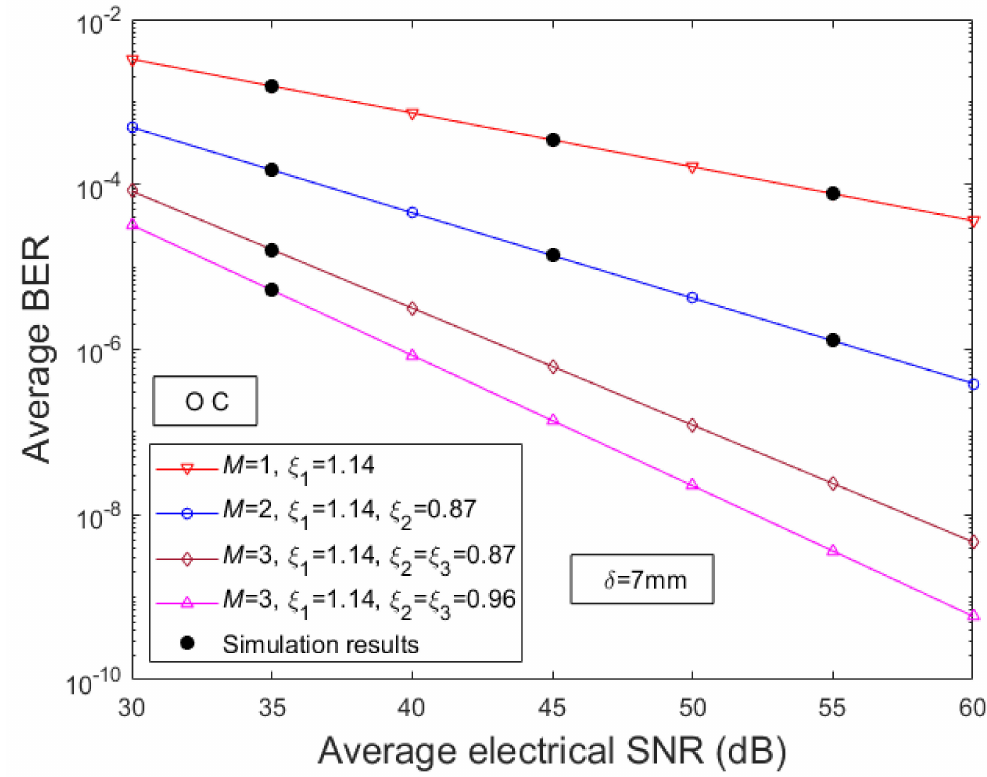
Figure 2. Average BER evolution over a wide range of electrical average SNR for various link configurations of δ m = 7 mm with spatial diversity and OC along withvarying generalized